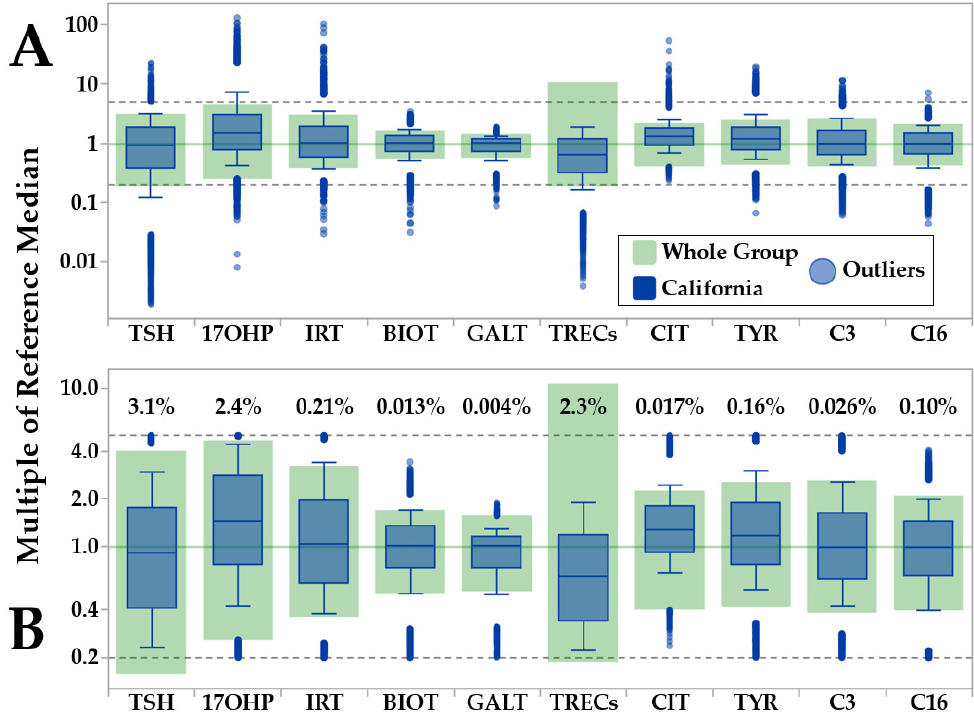
Figure 1. CLIR Data Validation Tool (pre- and post-outlier removal). Legend: Example of outlier removal by the CLIR Data Validation tool. Color coding is embedded in the top panel. (Panel A ): pre-outlier removal comparison between preliminary reference ranges (based on eligible cases) and data from the largest single cohort (California, N = 533,054). (Panel B ): post-outlier removal. Percent values above the file ranges refer to the proportion of case results that were removed for each marker.